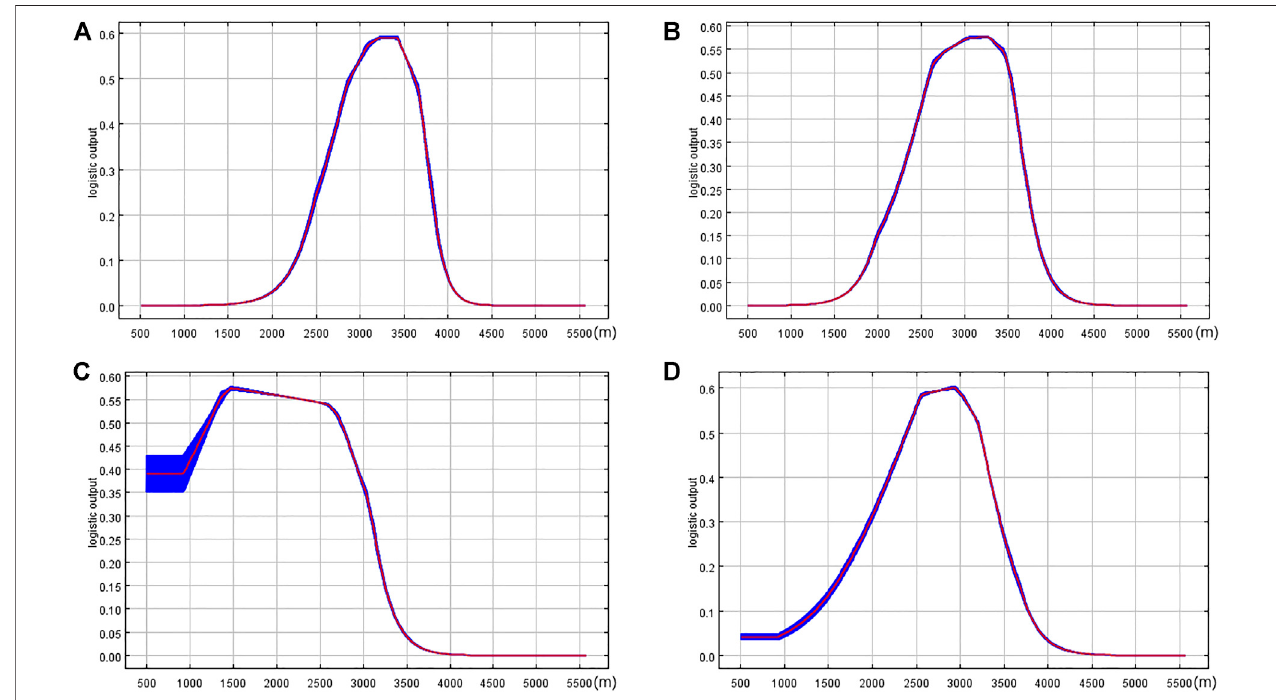
FIGURE 8 | Effects of altitude on the suitable area distributions of four dominant tree species: (A) Abies ; (B) Picea ; (C) Quercus ; and (D) Betula .